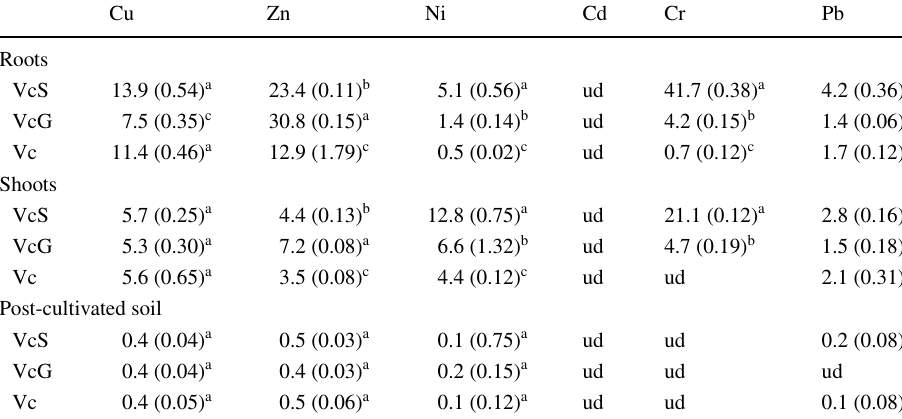
For each metal, means followed by different letters differ significantly (SNK test, p < 0.05) All values are in mg/kg −1